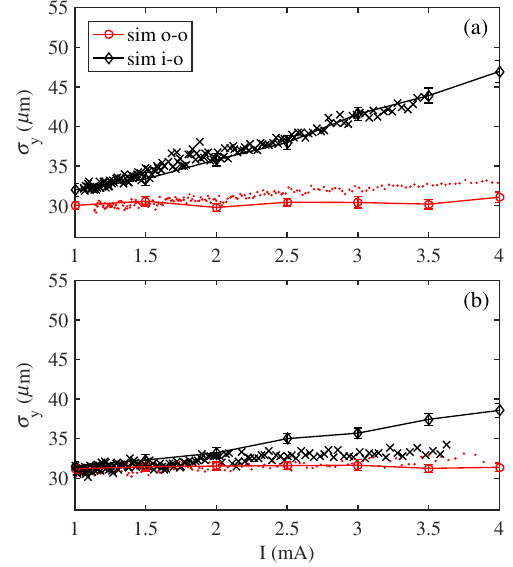
FIG. 9. (a) Measured vertical beam size σ y as a function of bunch current with coupling bumps (cp 11 ¼ (cid:3) 10 k) in lat − ð 0 Þ of electrons. (b) Measured vertical beam size contribution due to (cid:3) ffiffiffiffiffiffiffiffiffiffiffiffiffiffiffiffiffiffiffiffiffiffiffiffiffiffiffiffiffiffiffiffiffiffi (cid:4) σ 2 − σ 2 asymmetric scraper as a function of y; out-out y; in-out bunch